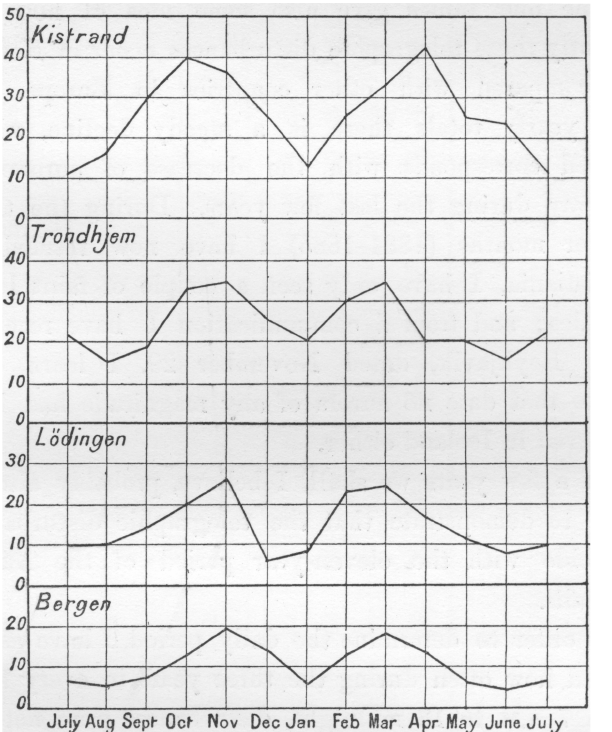
Figure 9. Seasonal variation in no. of occurrences of aurora-related disturbances on telegraph lines (from Tromholt, 1885a, vol. 1, p.